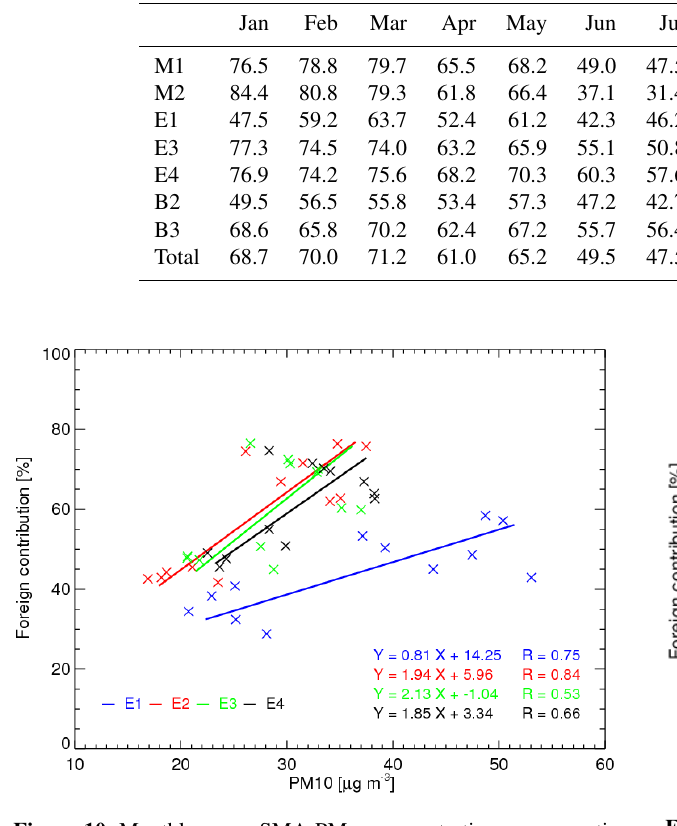
Figure 10. Monthly mean SMA PM 10 concentrations versus esti- mated contributions from foreign emissions sources.